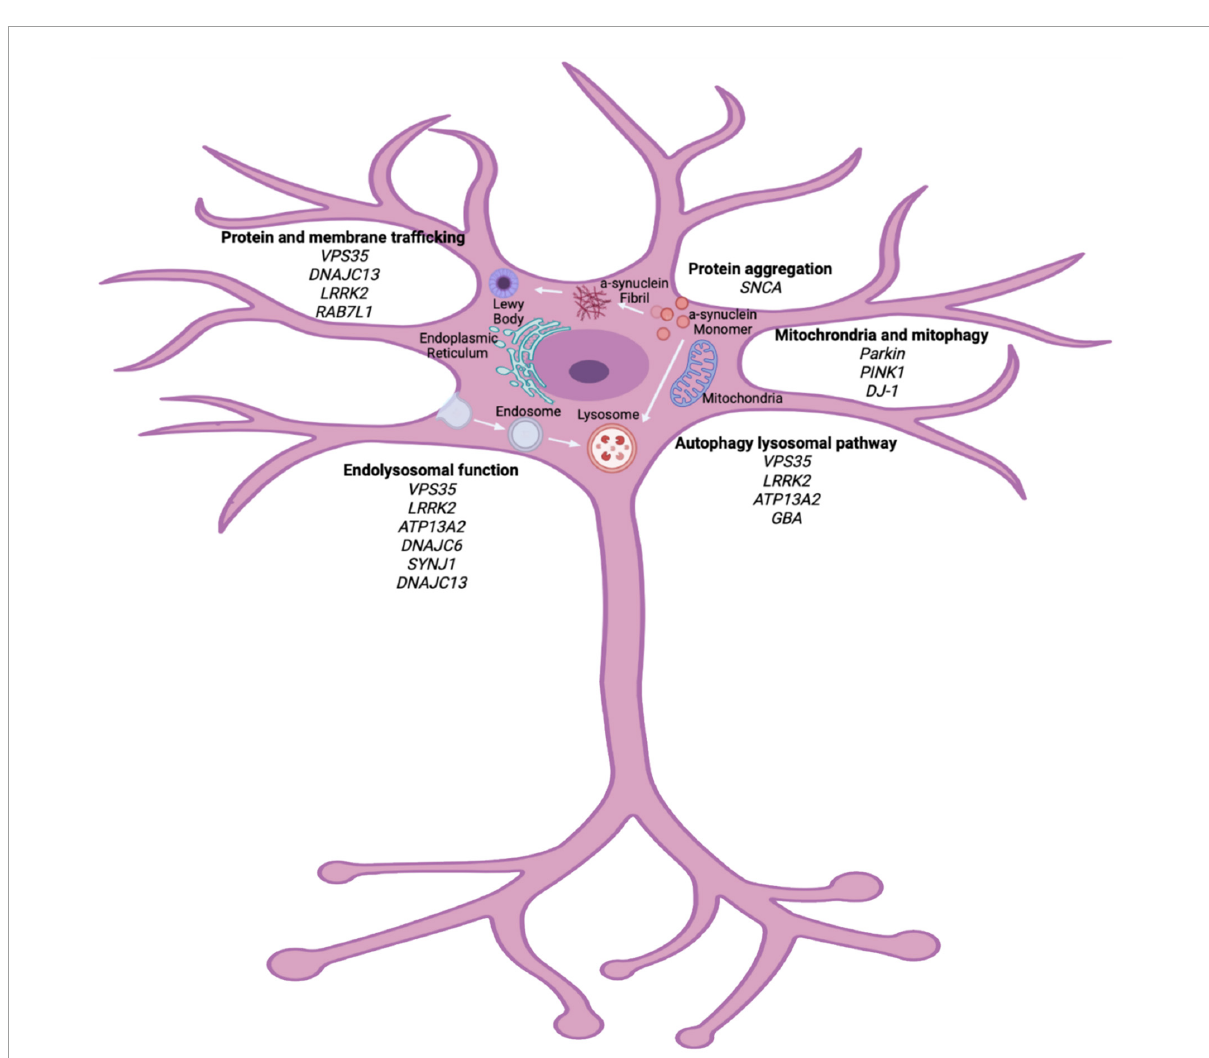
FIGURE1 Cellular pathways implicated in PD pathogenesis. Genetic studies of heritable PD have highlighted vital pathways that can contribute to the pathogenesis of PD. Organelle dysfunction within the neuron, due to many genetic and environmental factors, can lead to cellular stress and eventual neuronal death. Major pathways outline here implicate protein trafficking, endolysosomal dysfunction, autophagy lysosomal pathway and mitochondrial function as vital in PD pathogenesis. Biorender image (adapted from Polymeropoulos et al., 1997; Zimprich et al., 2011; Krebs et al., 2013; Macleod et al., 2013; Vilariño-Güell et al., 2013; Cilia et al., 2014; Fonseca et al., 2015; Ferreira and Gahl,